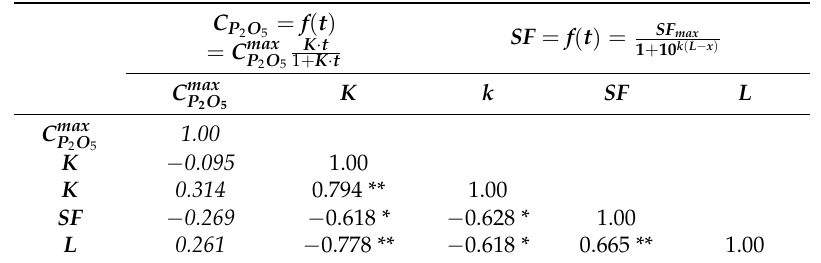
Table 3. The table of correlation factors between the parameters of considered kinetic describing models (* p < 0.1; ** p < 0.05), N = 10.